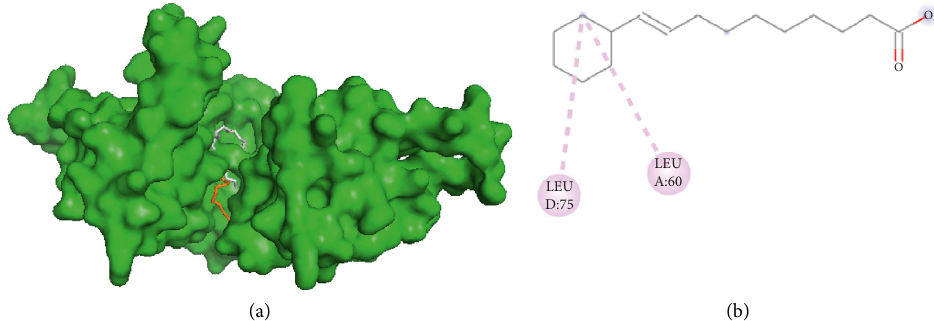
Figure 6: Interaction of oleic and palmitic acids with filaggrin. (a) 3D visualization: oleic acid (orange) and palmitic acid (grey). (b) 2D visualization: amino acid residues in oleic acid and palmitic